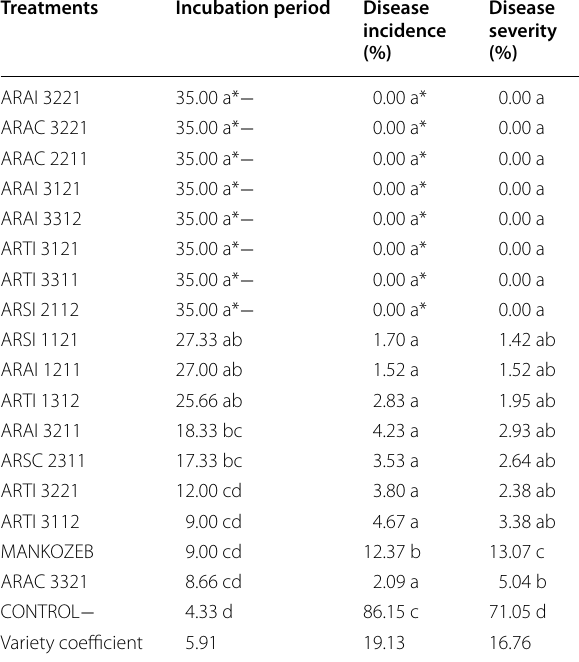
Table 2 The incubation period, disease incidence, and severity of anthracnose disease in chili plants that have been introduced to actinobacteria Treatments